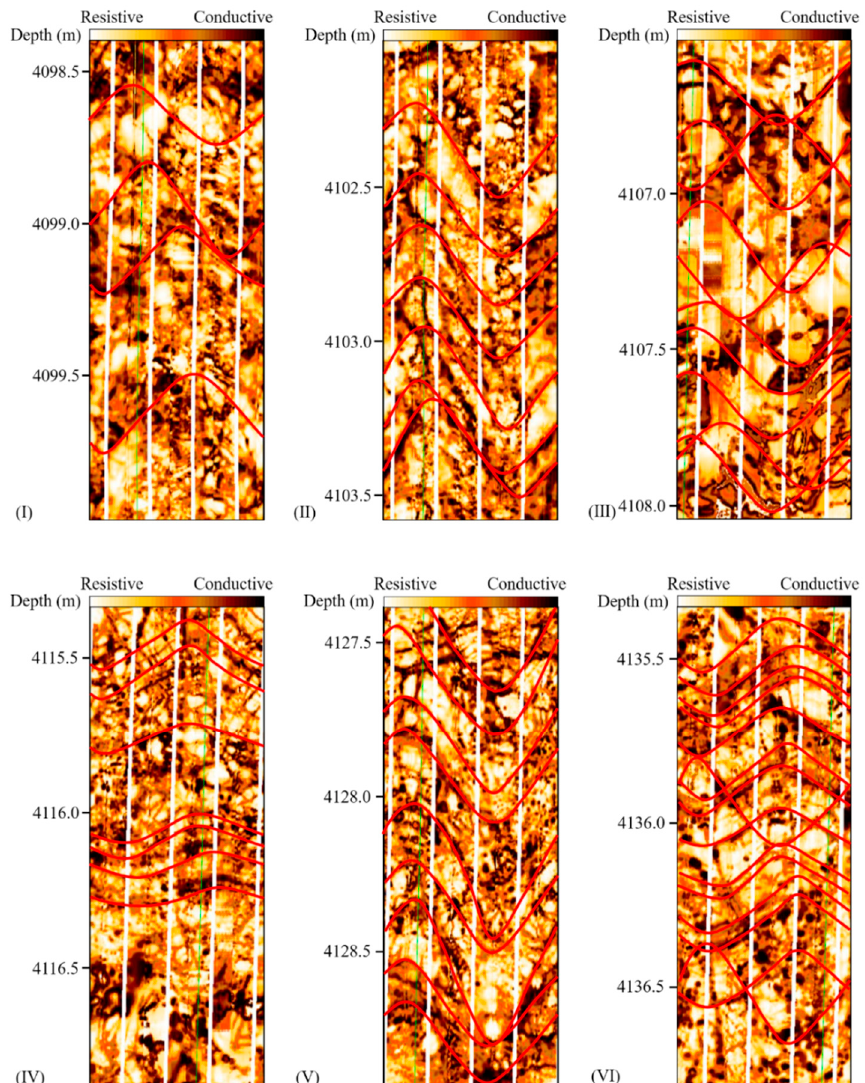
Figure 19. Tectonic fractures in the borehole image logs from Well R10. I to VI represent a part of each perforated interval, respectively. Perforated interval numbers are similar to Figure 18. Red lines represent tectonic fractures that appear as sinusoidal curves.